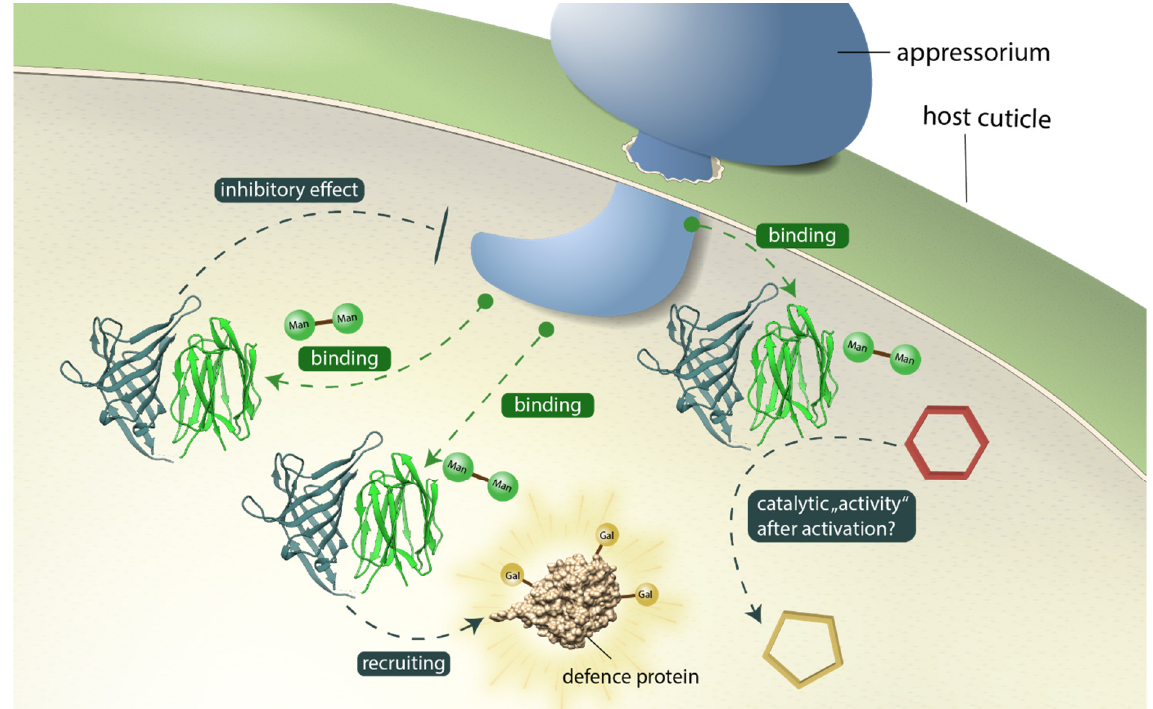
Figure 9. Potential contributions of Os JAC1 to pathogen defense at the fungal infection site. The Os JAC1-JRL domain (green ribbon) recognizes mannose glycoconjugates related to the membrane or proteins from plant or fungus. Antimicrobial mechanisms of the Os JAC1-DIR domain (metallic ribbon) include a direct inhibitory effect, recruitment of other defense-related proteins, and auxiliary enzyme activity. The red hexagon and yellow pentagon represents a putative, unknown compound to be converted.